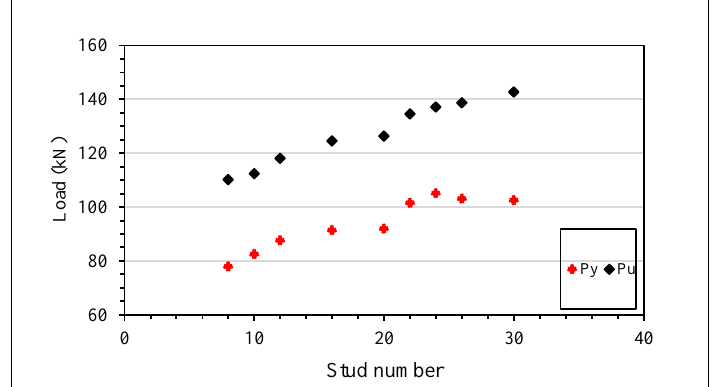
Figure 17. Yield, ultimate load-specimens relationship